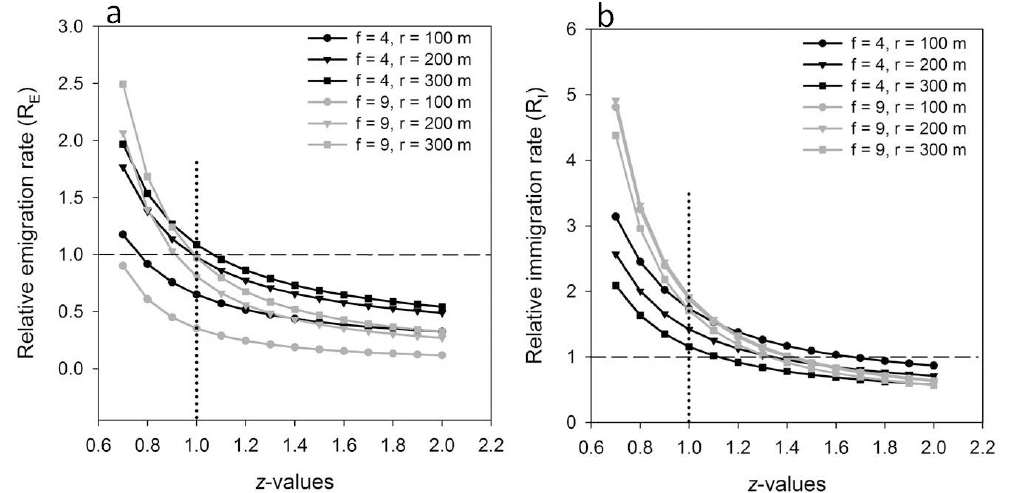
Figure 3. Relative e ff ect of habitat quality on (a) emigration rates and (b) immigration rates for di ff erent landscape scenarios. At a z value equal to 1 (dotted, vertical line), the e ff ective area equals the real area. R values along this line represent the relative e ff ect a particular patch structure has on emigration or immigration rates. When R = 1 (dashed, horizontal line), the quality weighted rates for a given landscape corresponds to the reference rates (i.e. scenario with f = 1, d = 100). The z value of the intercept between the dashed line and a given curve can be interpreted as the threshold at which the habitat quality is low enough to shift a positive e ff ect on emigration or immigration rates into a negative e ff